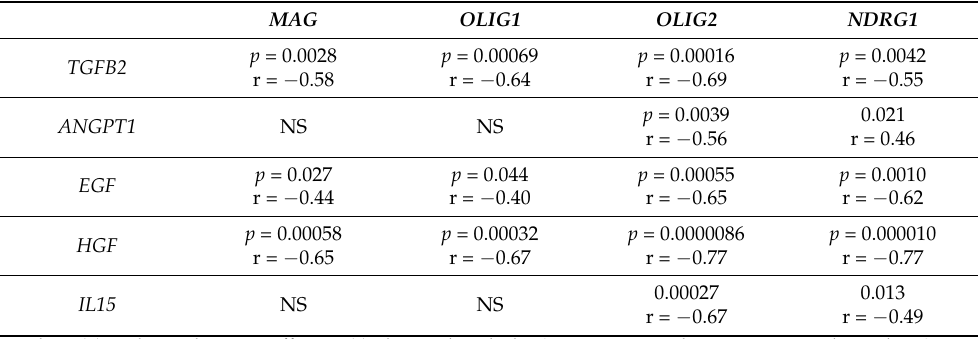
Table 1. Inverse correlations between the expression levels of candidate cytokine/chemokine/growth factor genes and oligodendrocyte